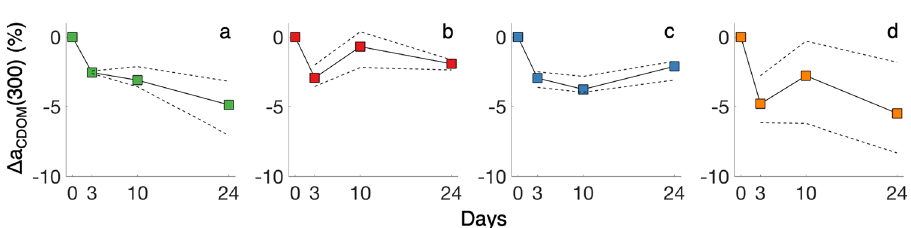
Figure 3. Median (solid line with colored squares) and interquartile range (dashed lines) for Δa CDOM (300) at each time point relative to initial a CDOM (300) for ( a ) 0.2 μm, ( b ) 0.7 μm, ( c ) 3.0 μm and ( d ) 3.0 μm-after-PB